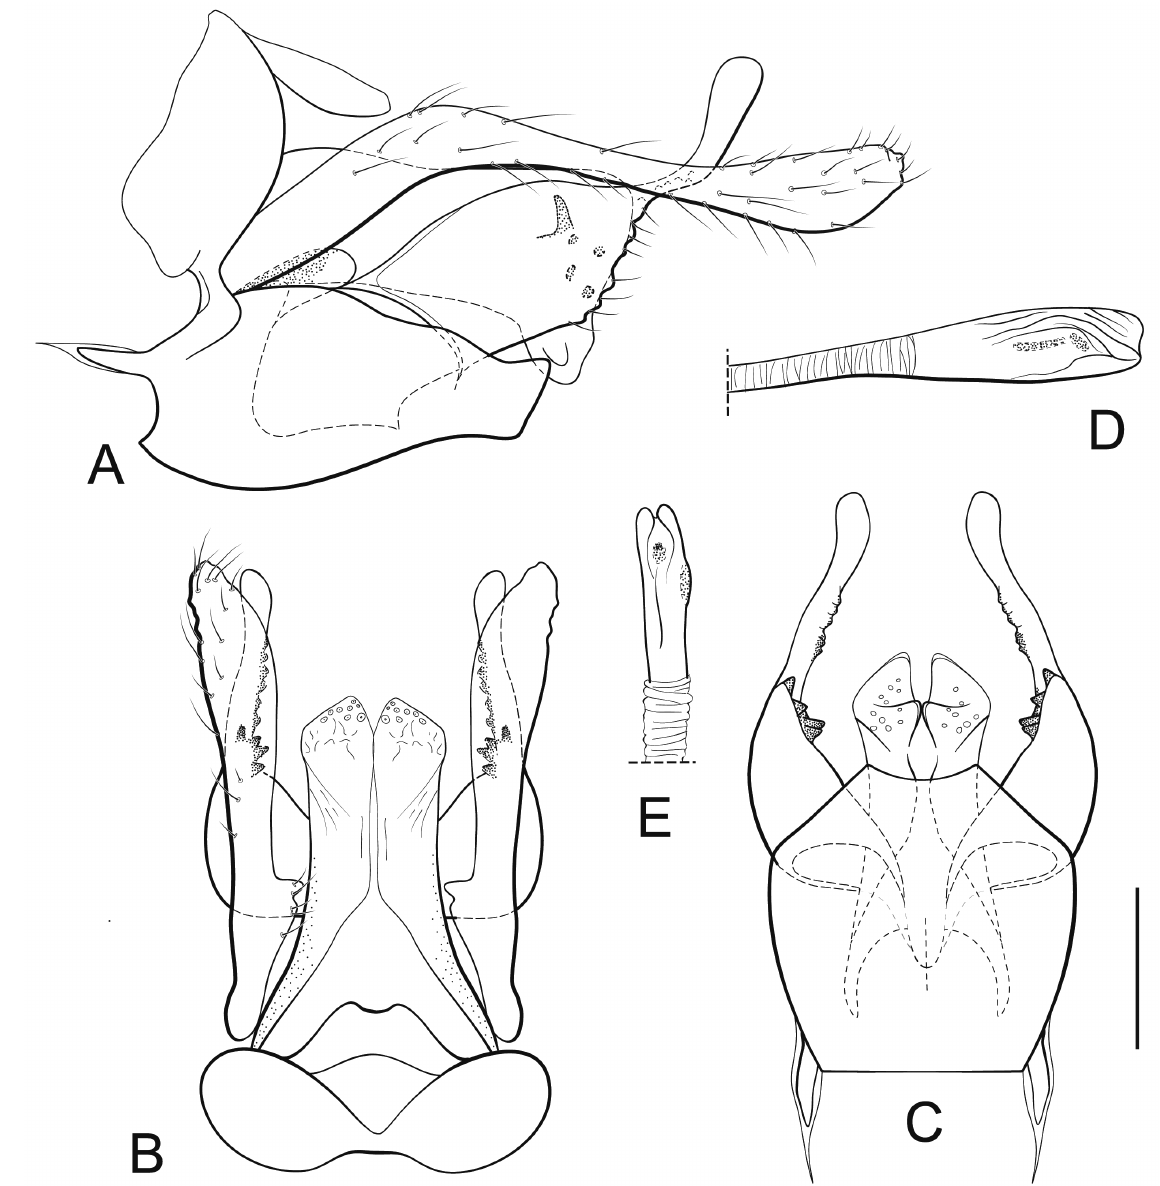
Fig. 9. Xiphocentron ( Antillotrichia ) tijuca sp. nov., holotype, adult, ♂, genitalia. A . Left lateral view. B . Dorsal view. C . Ventral view. D . Phallus apex, left lateral view. E . Phallus, apex in dorsal view. Scale bar = 0.1